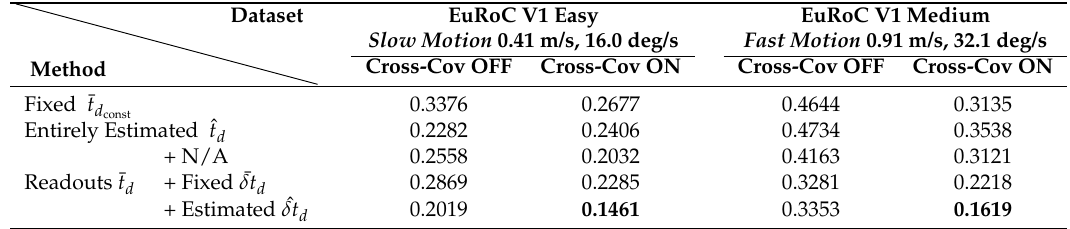
Table 3. Sensitivity analysis in RMS position error [m] of latency compensated VIO.